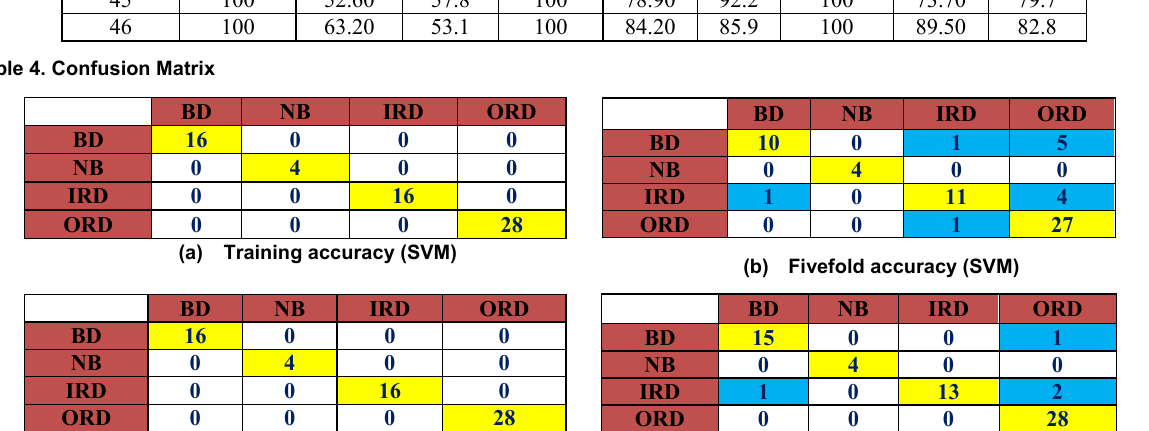
Table 4. Confusion